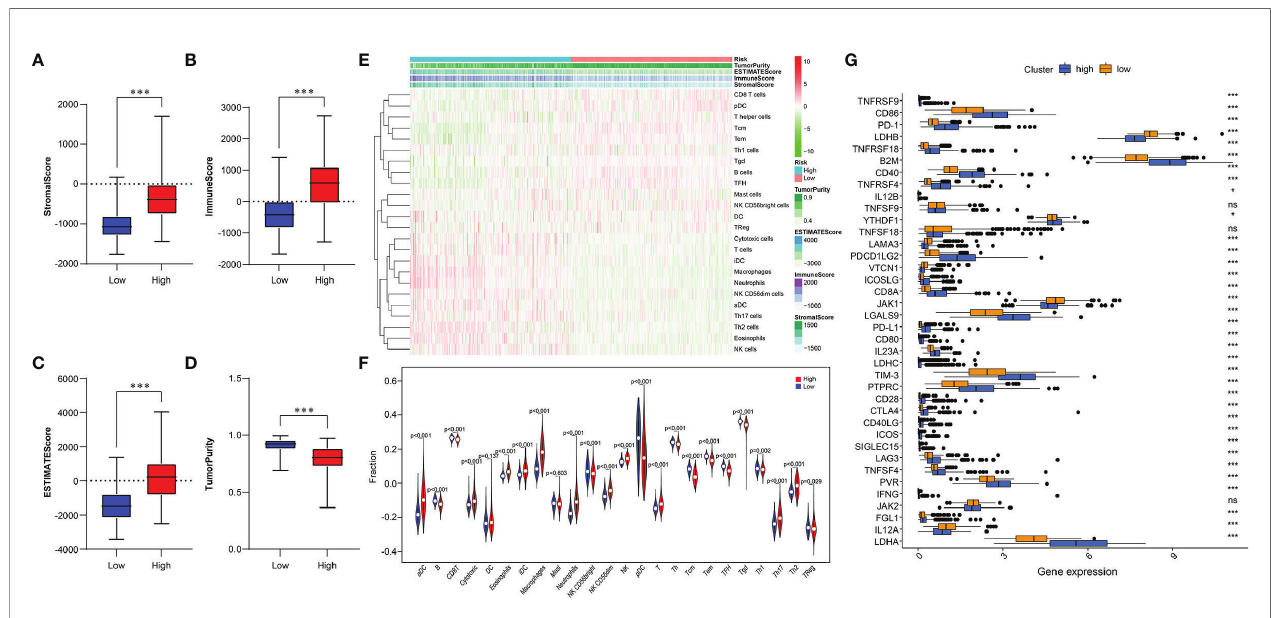
FIGURE 6 | Relationship between immune in fi ltration and immune checkpoint and risk model. (A-D) Comparison of Stromal Score (A) , Immune Score (B) , ESTIMATE Score ( C ), and Tumor Purity (D) between two risk subgroups. (E) The enrichment levels of 24 immune cells in two risk groups. (F) Violin plot displayed the different proportions of tumor-in fi ltrating cells between the two risk groups (blue was the low-risk group, and red was the high-risk group). (G) The boxplot shows the expression of 38 immune checkpoint molecules between the two risk subgroups. *p < 0.05, ***p < 0.001; NS, no signi fi